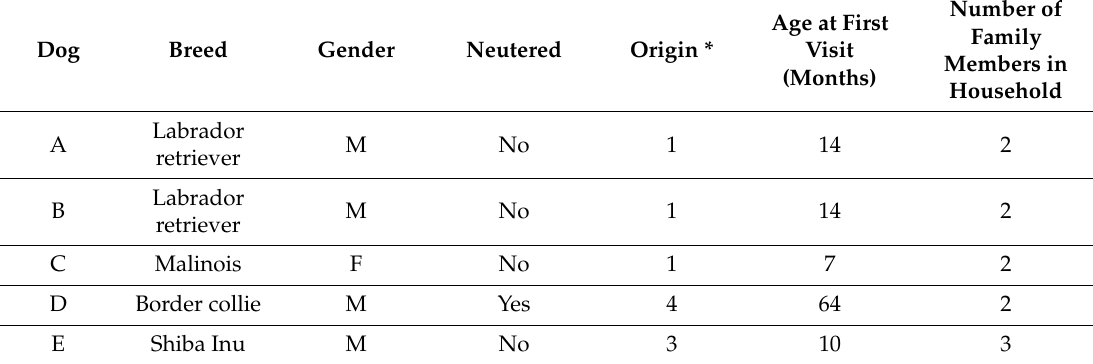
Table 1. Breed, gender, neutering status, origin, age at first visit to the counsellor, and living conditions of five dogs with social impairment towards their owners.